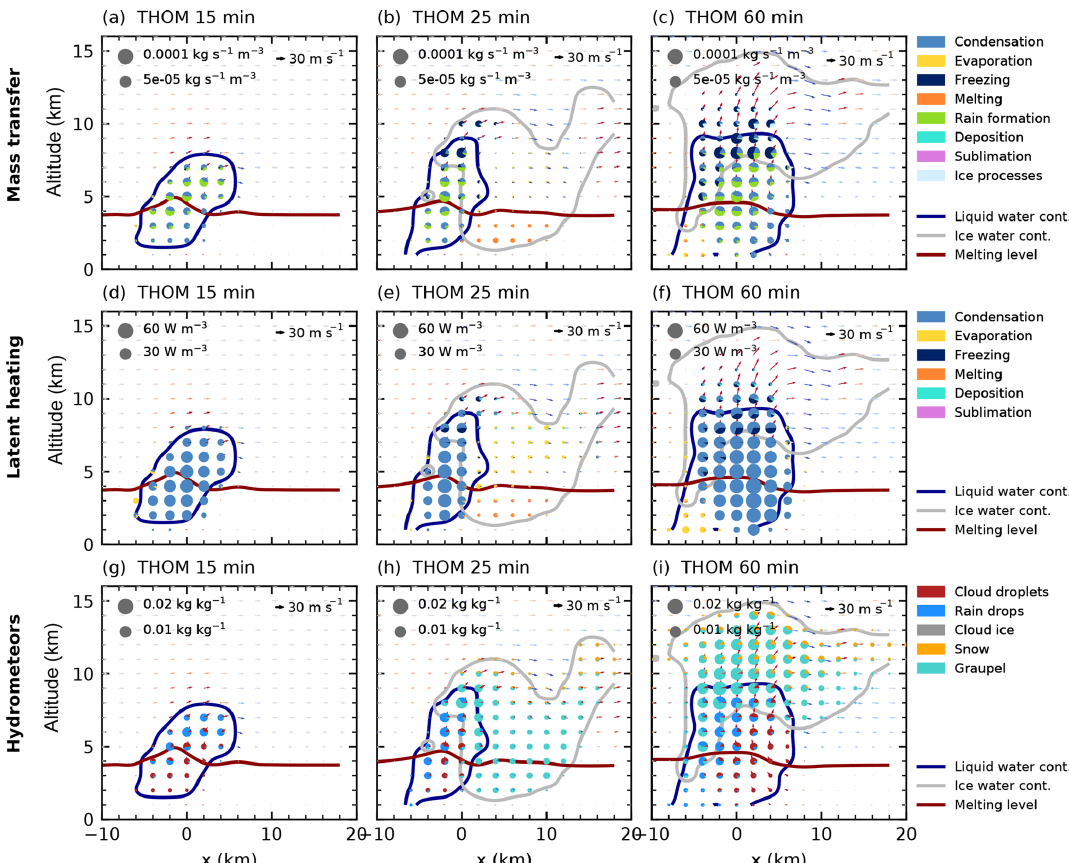
Figure 3. Cloud microphysical morphology along a slice parallel to the cell track for a cloud droplet number concentration of 250cm − 3 for the Thompson microphysics scheme as in Fig.